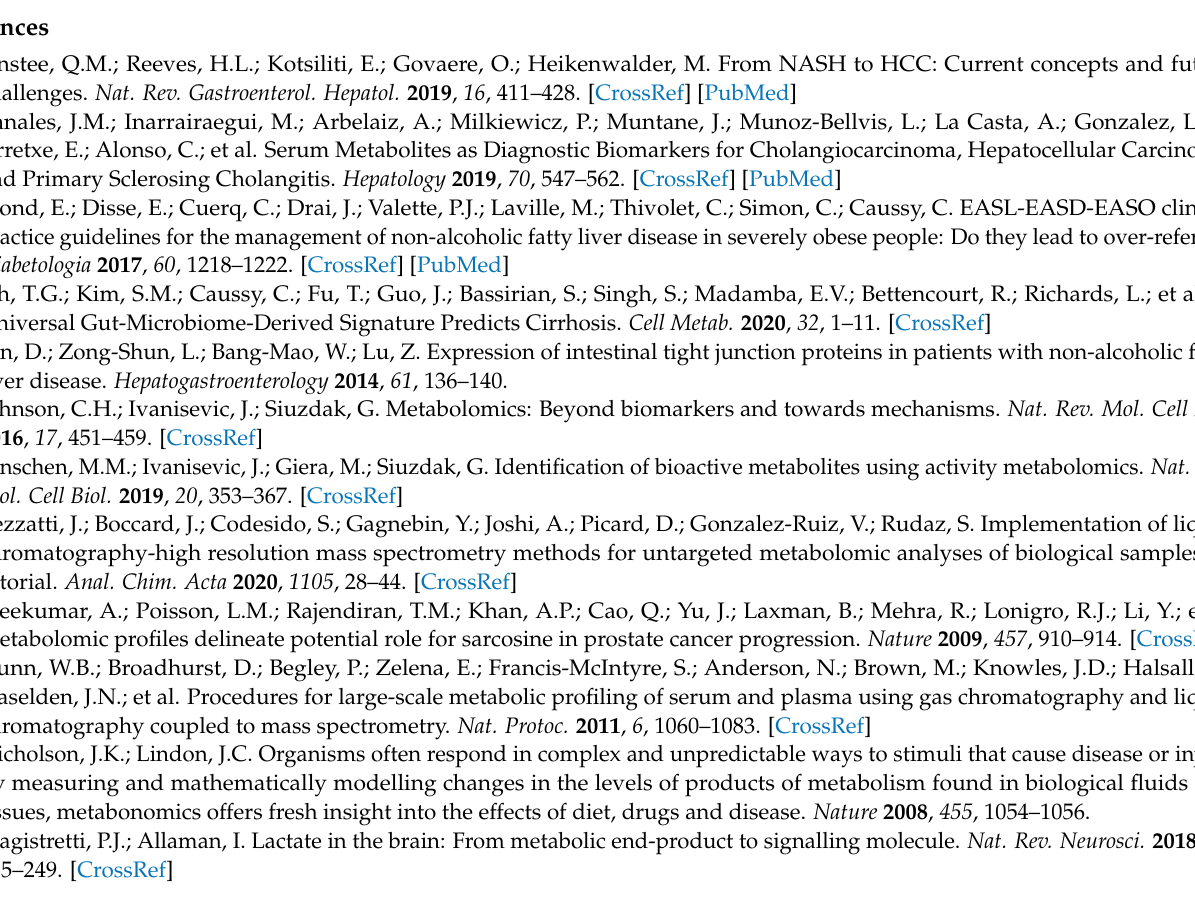
Table S2: Summary of differential metabolites in serum between different groups. Table S3: Summary of differential metabolites in intestine content between different groups. Table S4: Biochemical parameters of different groups. Table S5: Body weights prior to the onset of treatment (CCl 4